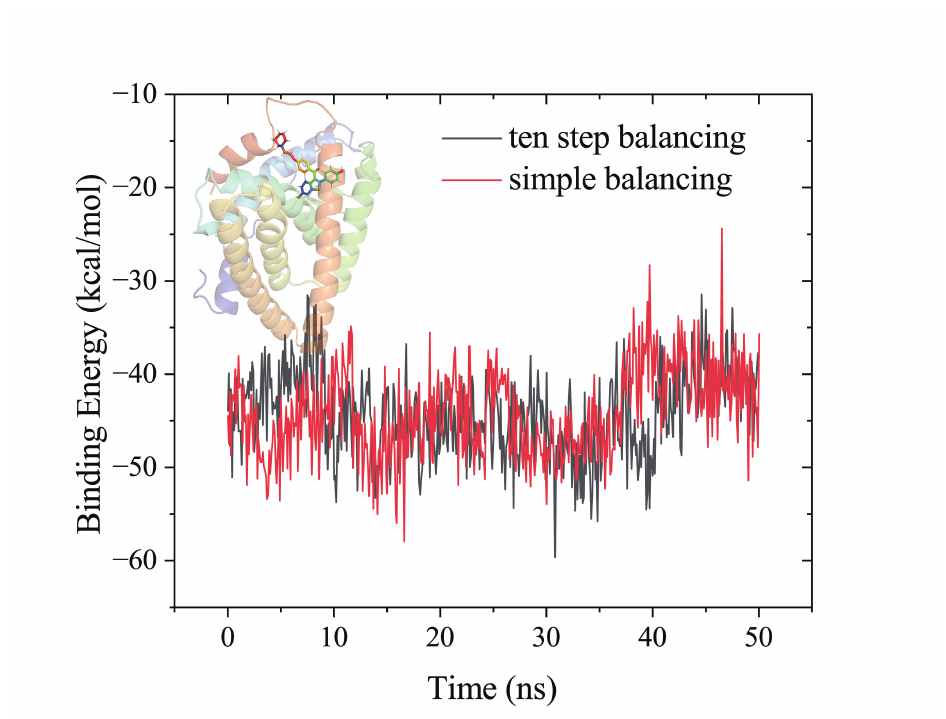
Figure 2. Comparison of the MM-PBSA results from 50 ns MD simulations of the raloxifen-estrogen receptor, using the ten step balancing or simple balancing in the Amber tutorial, using the Amber- MDrun script.